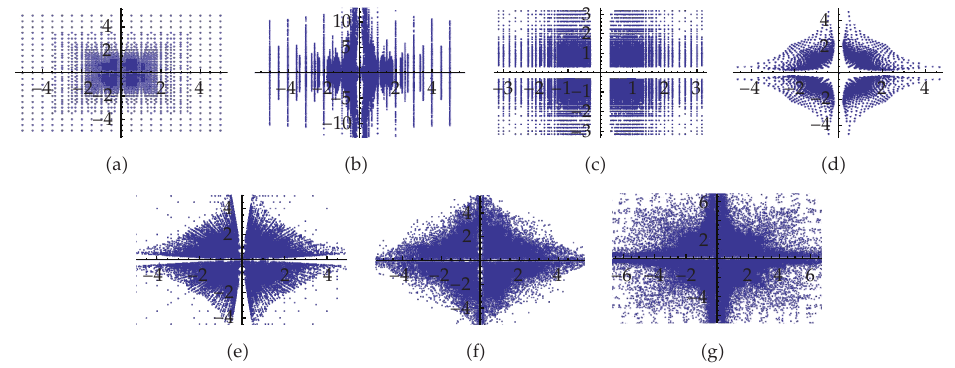
Figure 13: In reference to the toric diagrams in Figure 11, for each Calabi-Yau threefold geometry, we find the corresponding Newton polynomial as a real algebraic curve. We sample over 50000 random integer coe ffi cients in the range (cid:3) − 10 , 10 (cid:4) , and isolate the real critical points in R 2 , which are then plotted collectively for (cid:5) b (cid:6) conifold, (cid:5) c (cid:6) SPP, (cid:5) d (cid:6) F 0 , and (cid:5) e, f, g, h (cid:6) dP 0 , 1 , 2 , 3